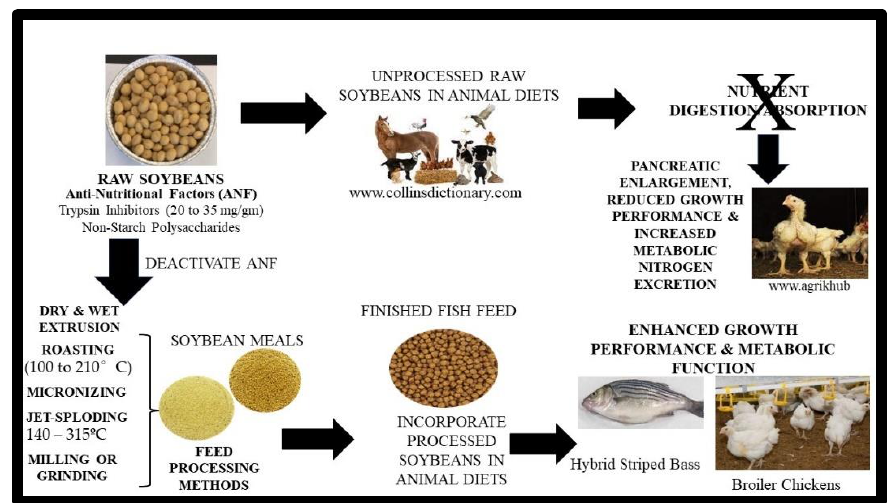
Figure 3. Soybean Post-harvest Processing and Utilization in Animal Diets. Soybean seeds were cultivated and harvested by the Soybean & Nitrogen Fixation Unit, ARS, U.S. Dept of Agriculture (Raleigh, NC). Raw soybeans were thermally processed in meals at Mule City Specialty Feeds (Benson, NC, USA) and finished fish feed was prepared at Zeigler Feeds (Gardners, PA). Domesticated juvenile striped bass were reared at the Marine Aquaculture Research Center at NC State University (Smyrna, NC). Male broiler (Ross 708) chickens were raised at the NC State University Chicken Education Research Center (Raleigh, NC).